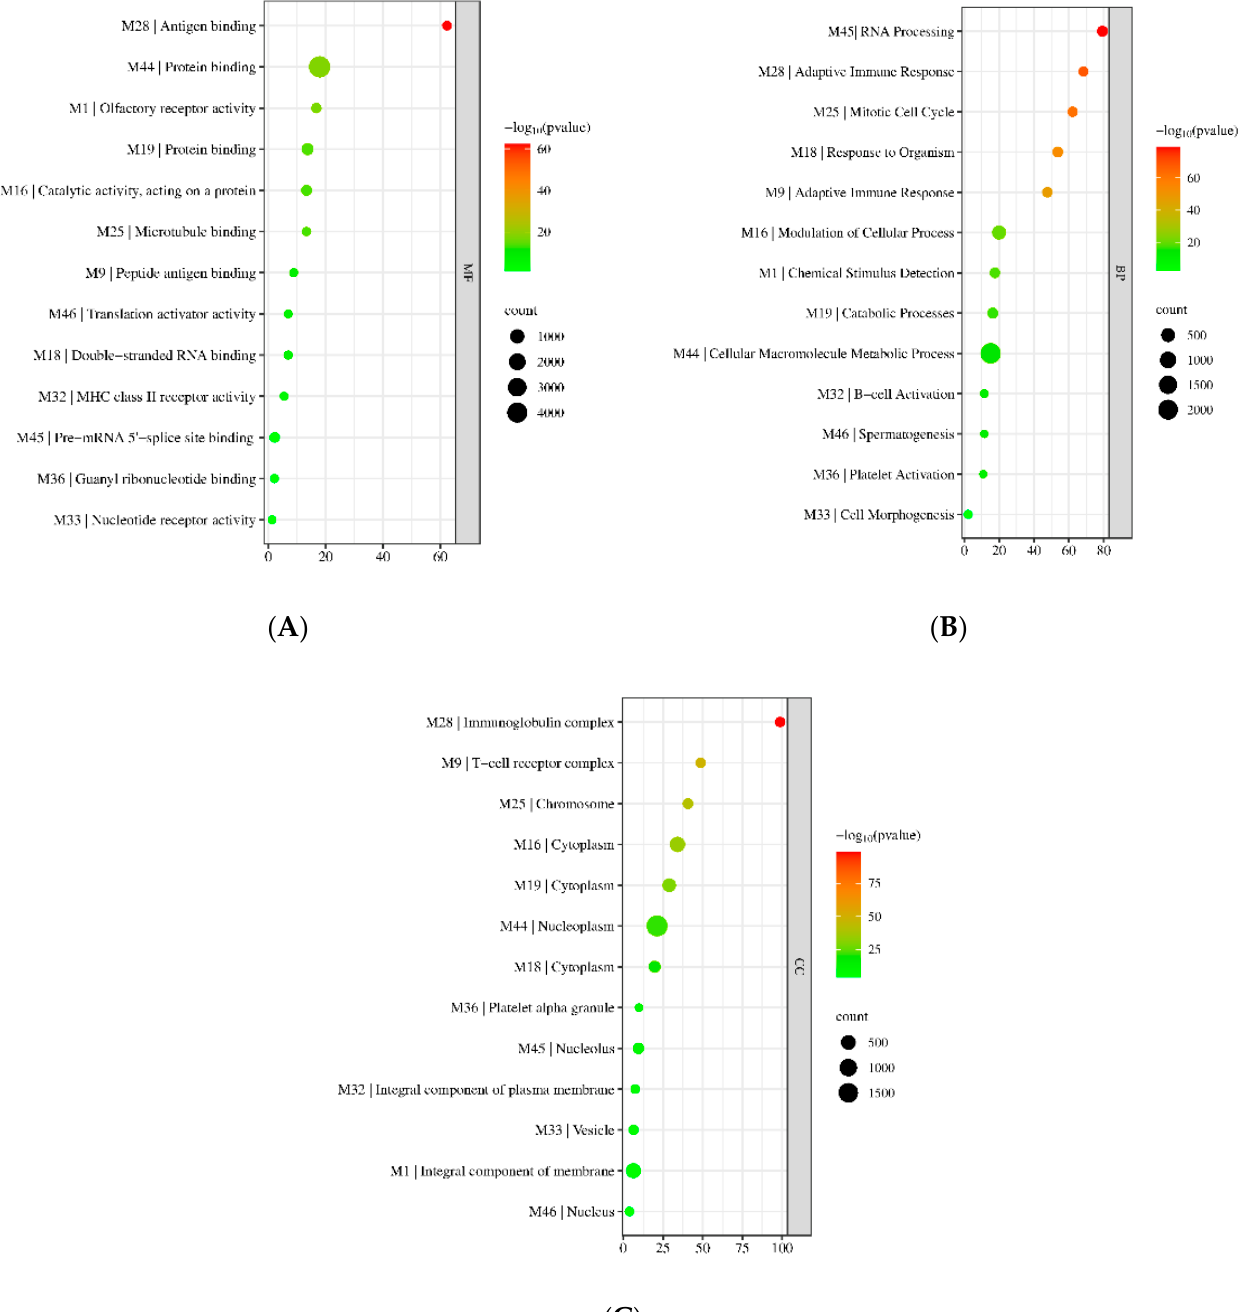
Figure 5. Bubble plots for the enriched ( A ) molecular functions (MF), ( B ) biological processes (BP), and ( C ) cellular components (CC) for each preserved module.